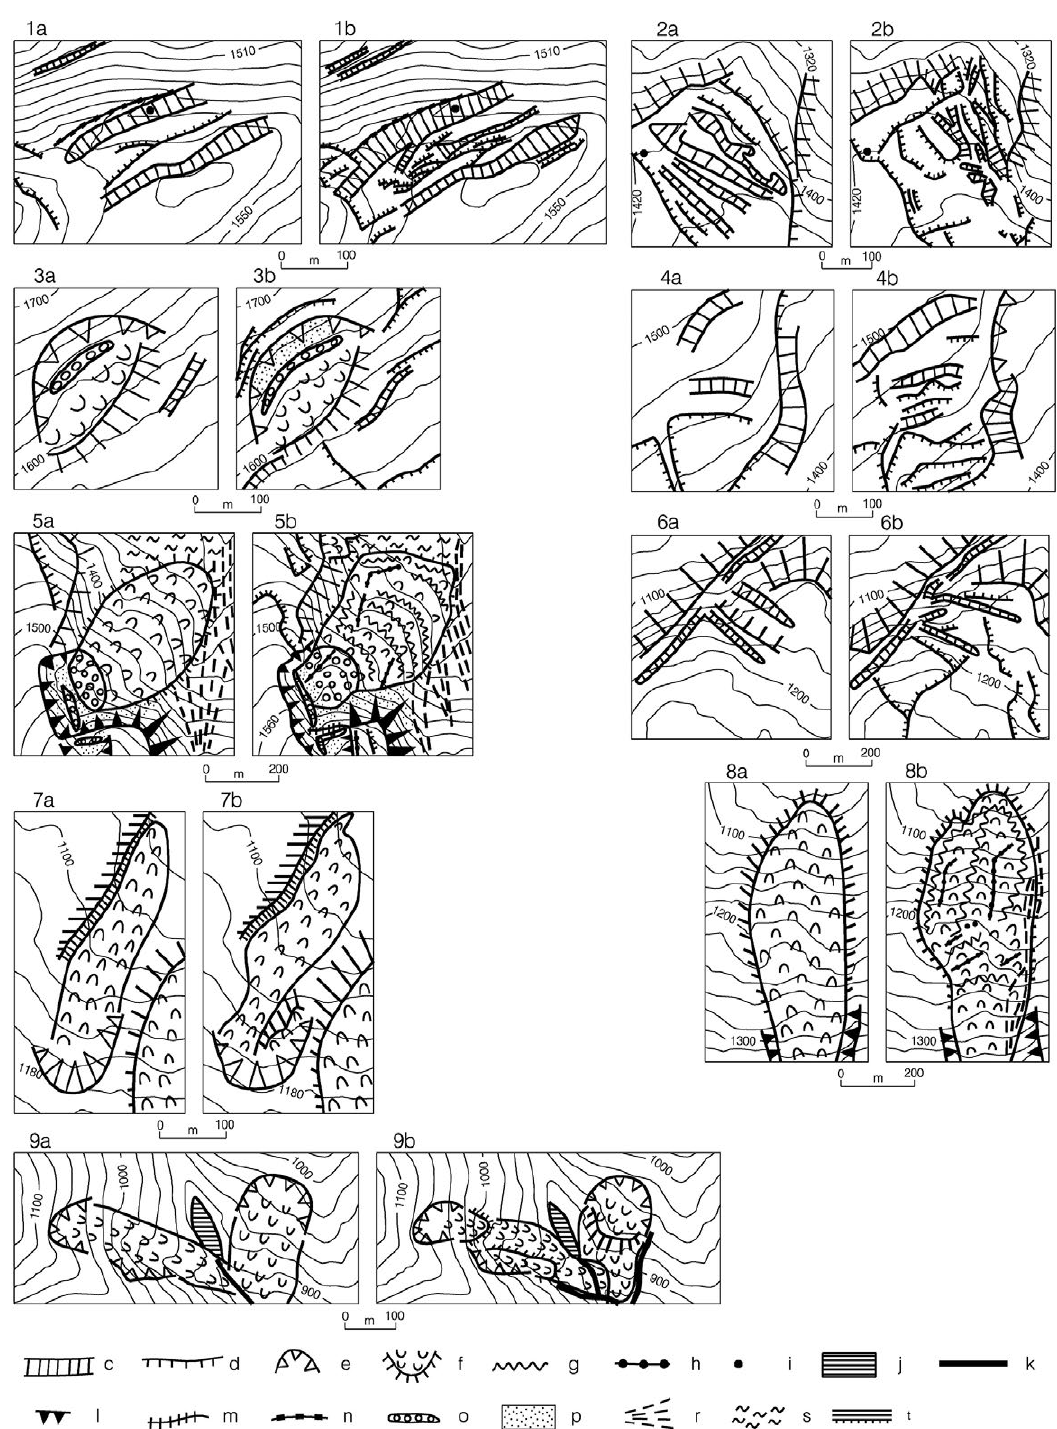
Fig. 11. Comparison of the limit of landslide forms and forms of other origin in the test areas 1–9 basing on: a – geomorpho- logical map of Babia Góra Mt., b – LiDAR images. Shaded Relief map, c – ridge and slope trenches, d – landslide escarp- ments, e – landside headwalls, f – colluvial tongues, g – axes of linear swellings on colluvial tongues, h – axes of linear depressions on colluvial tongues, i – landslide lakes, j – flat valley bottom in the place of deposit filling of former landslide lake, k – gorges of streams cutting across the landslide tongues, l – steep slopes in the place of glacial undercutting, m – convex bend between glacially re-modelled headwalls located at different heights, n – sharp rocky crest, o – nival rampart (inactive), p – debris slope, r – torrential cones with fossil debris flows, s – moraines degraded by landslides, t – high terrace with an